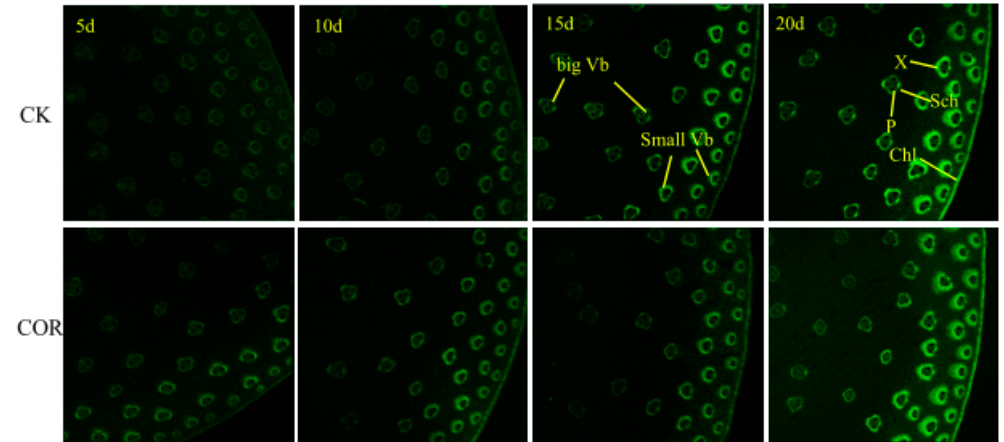
Figure 4. Fluorescence micrographs showing di ff erences in the lignin composition in the walls of sclerenchyma cells and vascular bundles (sections were taken from the middle of the third internode) of maize inbred line B73 stems at di ff erent days after COR was sprayed onto foliar surfaces. CK: control treatment; COR10: 10 µ Mol L − 1 COR treatment. 5 d, 10 d, 15 d, and 20 d: respectively 5, 10, 15, and 20 days after COR treatment. Small vascular bundle (Vb): underdeveloped Vb, which are close to the edge of the stem; Big Vb: mature Vb, which are distributed in the central of the stem; P: phloem; X: xylem; Scl: sclerenchyma; Chl: chlorenchyma.